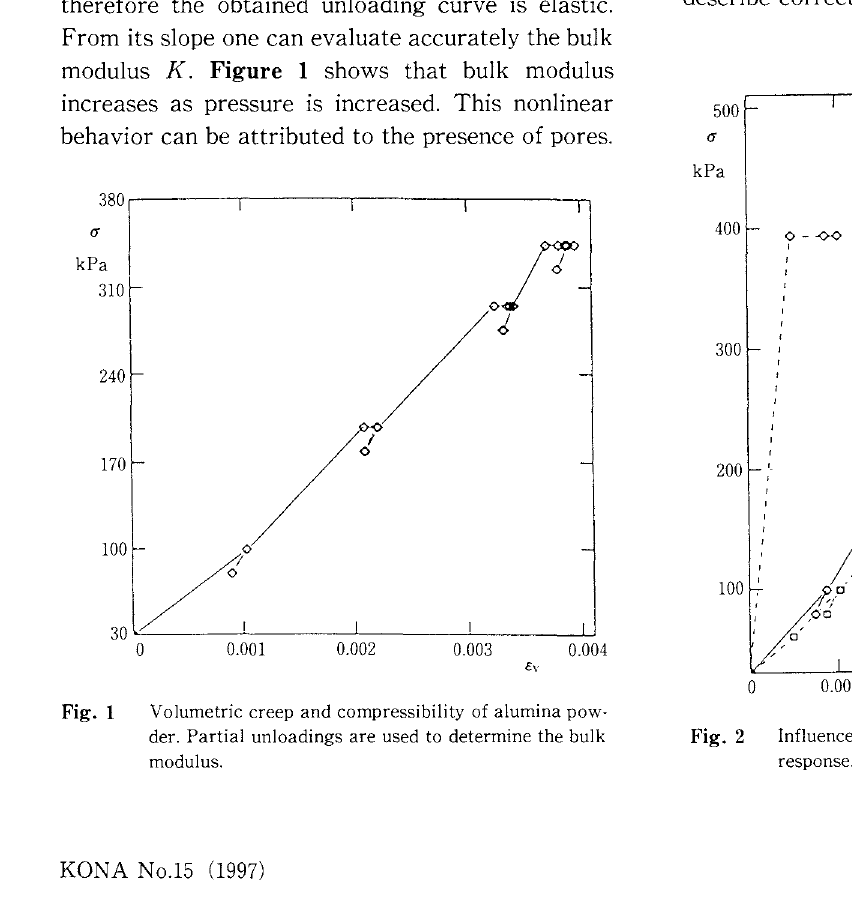
Influence of the loading history on the hydrostatic